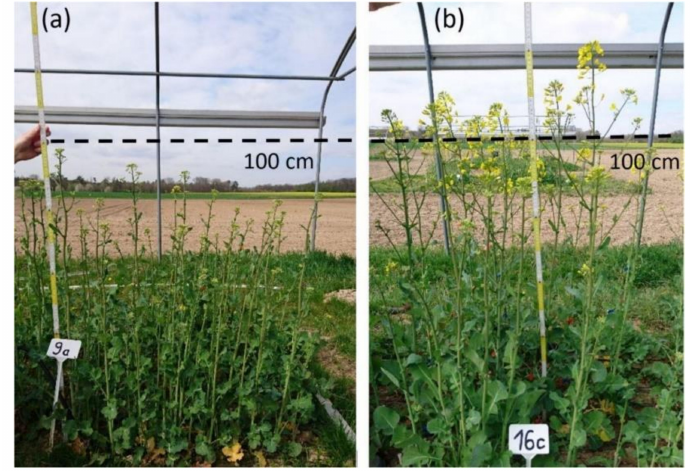
Figure 3. Di ff erences in canopy height and crop development of OSR (oilseed rape) on 11 April 2017. Plants were grown either ( a ) under ambient soil temperature or ( b ) under soil warming. In ( a ) under control conditions, canopy height was up to 100 cm and plants were in development stage DC 59–DC 60. OSR under soil warming ( b ) was up to 120 cm high and in development stage DC 60–DC 65. The BBCH decimal code (DC) is used to define the development stages of the plants